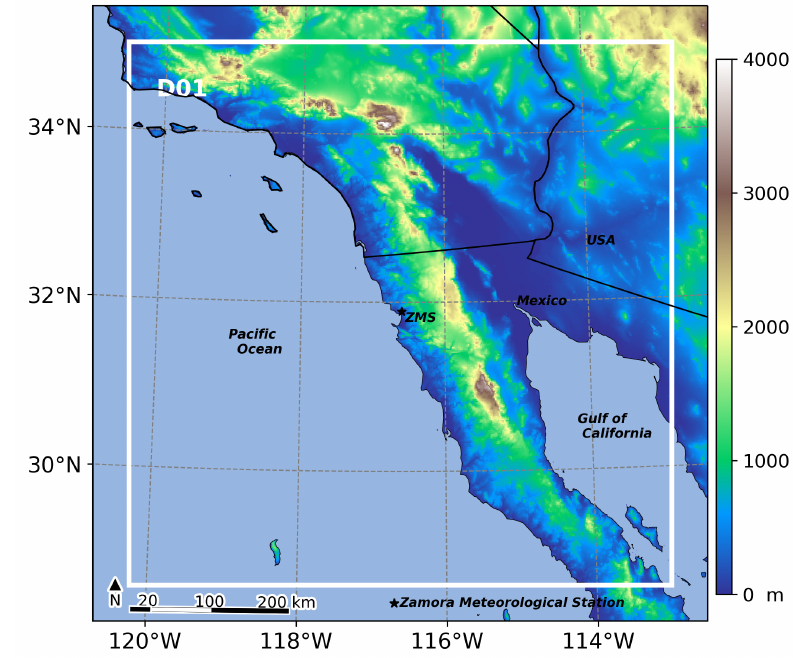
Figure 1. Case Study area. The star with the ZMS label near the center of the domain shows the approximate location of the Lopez Zamora Meteorological